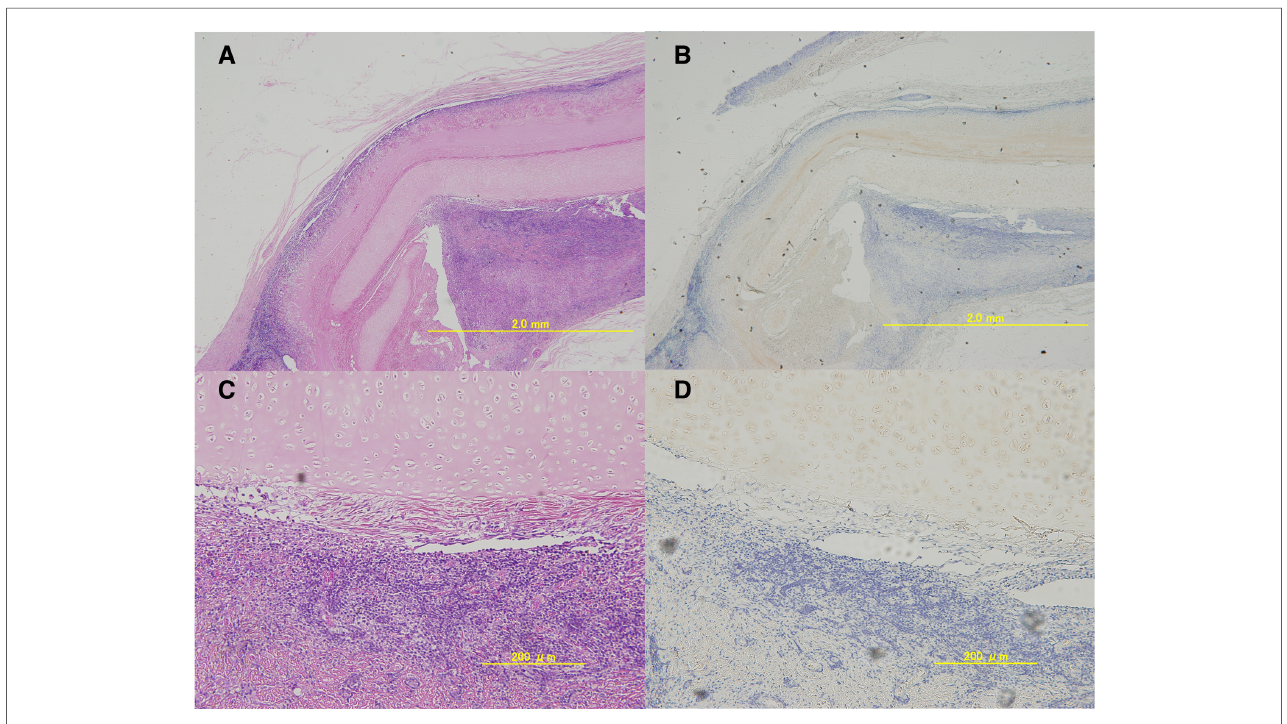
FIGURE 5 Microscopic images of the excised porcine extracellular matrix (P-ECM) (( A ); 4×, ( B ); 20×).longitudinal hematoxylin and eosin-stained tissue section. An in fi ltrate of lymphocytes and polynuclear leukocytes was observed around the decellularized cartilage tissue. However, CD3 staining(( C ); 4×, ( D );20×) was clearly negative and no obvious rejection was